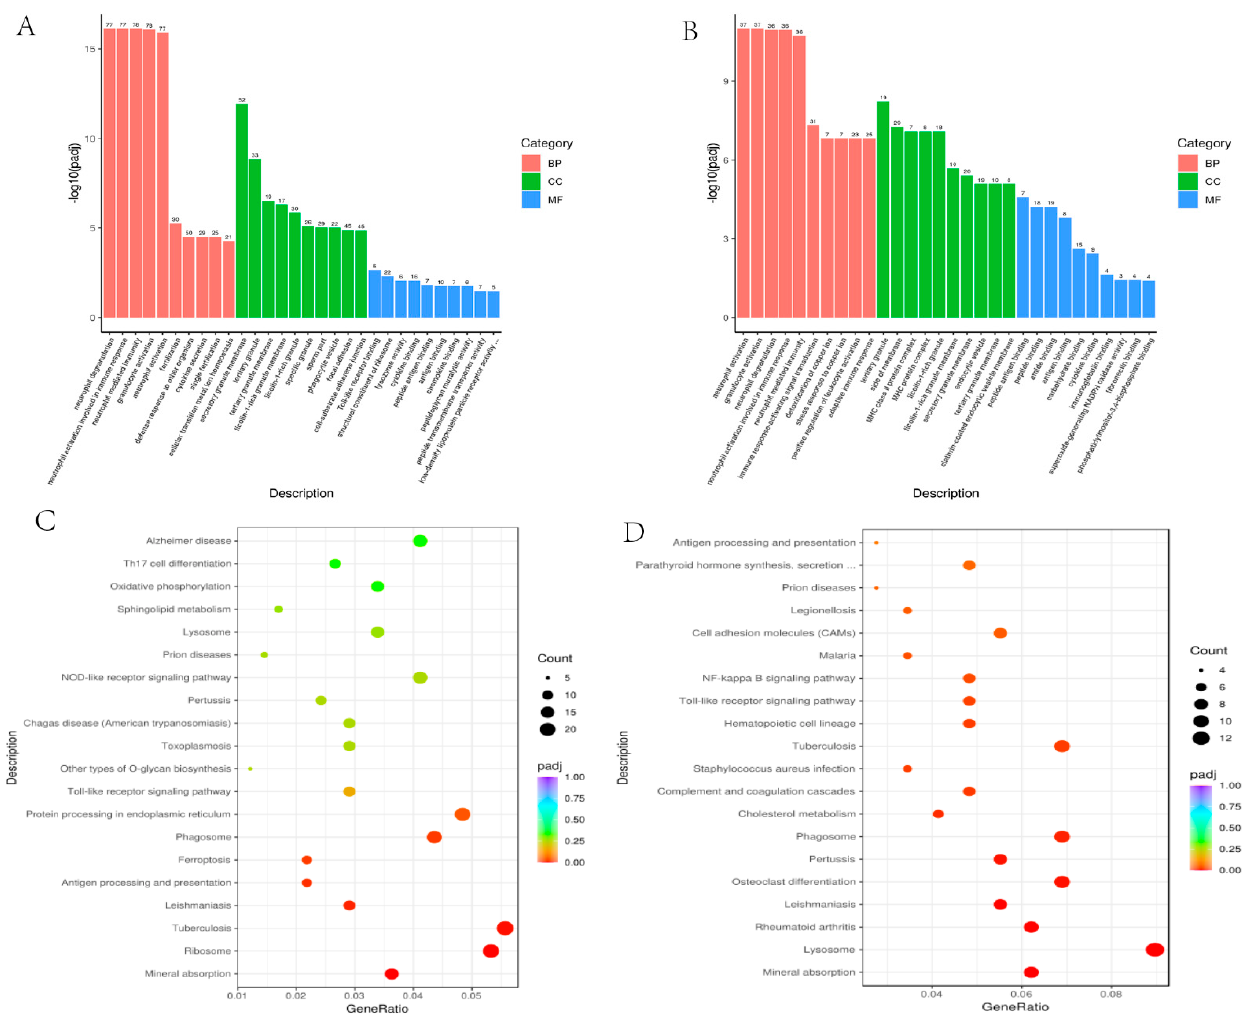
Figure 2. ( A ) Significant Gene ontology terms in Slow freezing group (biological process); ( B ) Significant Gene ontology terms in Vitrification group (biological process); ( C ) Bubble chart of significant KEGG pathways in Slow freezing group; ( D ) Bubble chart of significant KEGG pathway in Vitrification group.